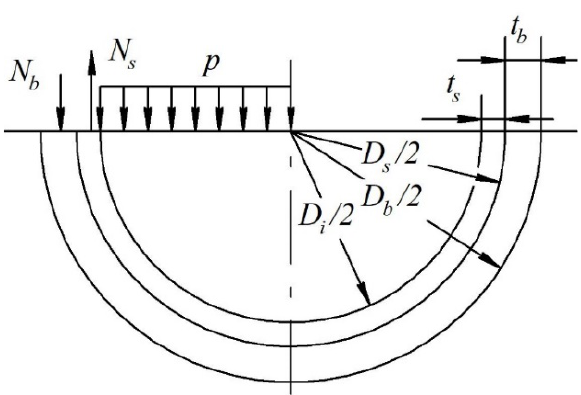
Fig. 2 . Equal balance of a half-ring cut from a pipe under the action of internal pressure (during repairing a pipeline